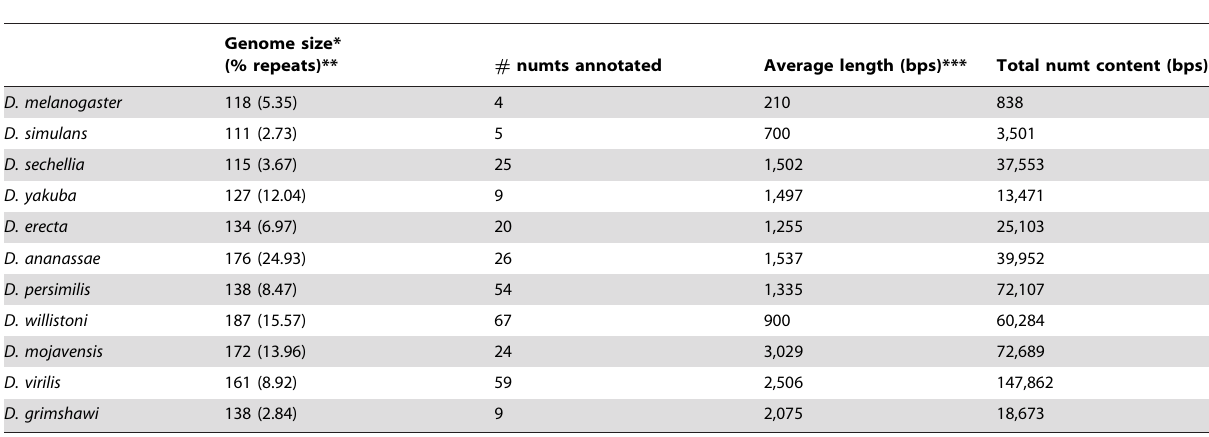
Table 1. Numbers of numt annotations in 11 Drosophila